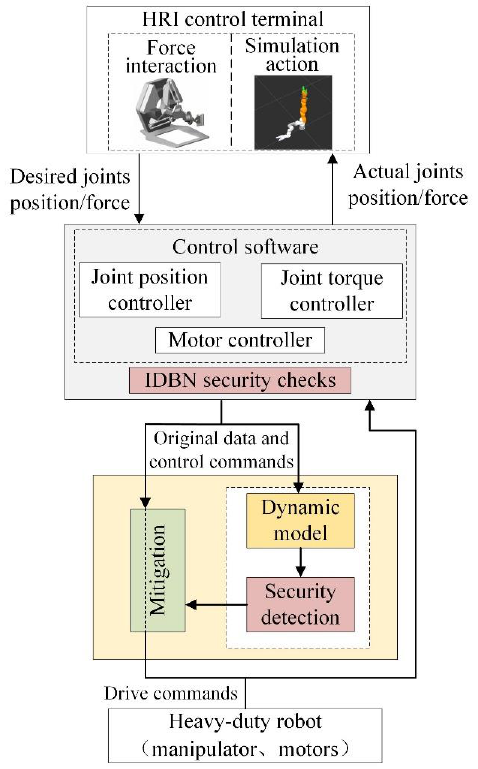
Figure 7. Detection and mitigation mechanism.